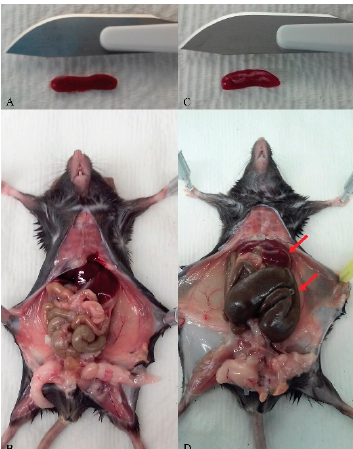
Figure 3. Germ-free and control mouse macroscopic phenotype. ( a ) and ( b ): Control C57BL/6 mouse, three-month-old male. Phenotype: typically, fat; normal spleen, liver, and cecum. ( c ) and ( d ): Germ-free C57BL/6 mouse, three-month-old male. Phenotype: lean, no fat; smaller spleen and liver, and enlarged cecum (5 ×). Pictures are representative of the mouse cohort and genders.